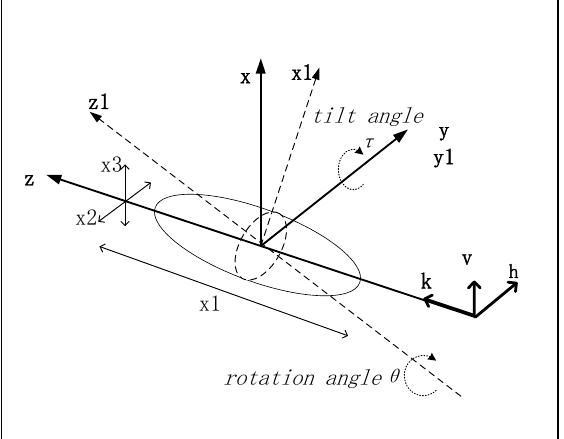
Figure 2. Ellipsoidal particle model in the Cartesian coordinate system. Given an ellipsoidal scatterer with axes x1, x2, x3 (x1 > x2 = x3); and Eulerian tilt and rotation angles of τ and θ , respectively, relative to the radar line of sight ‘k’, both